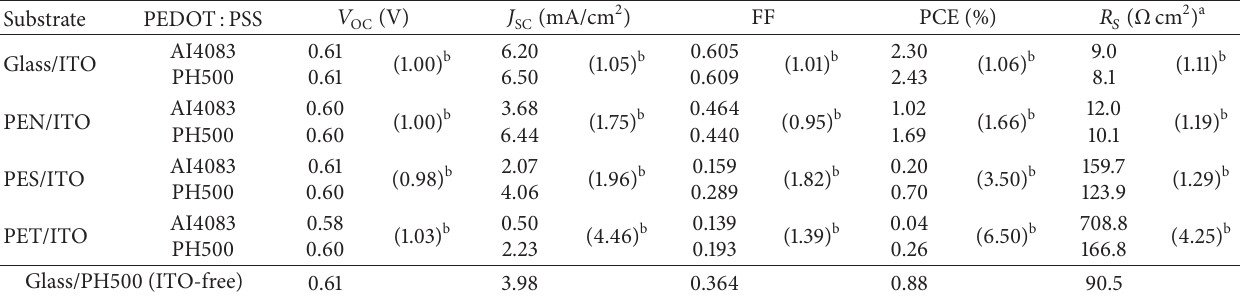
Table 1: Summary of device parameters for organic photovoltaic devices with four different ITO substrates (glass and flexible plastics) and two different buffer layers (AI4083 and PH500).